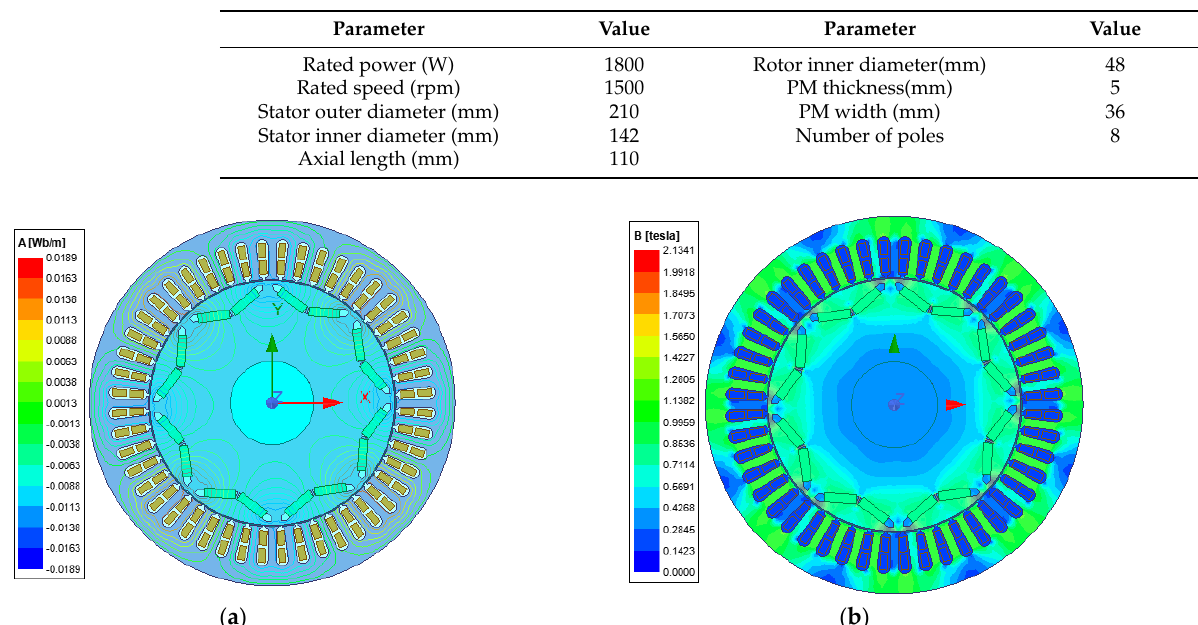
Table 1. Main parameters of PMSM.